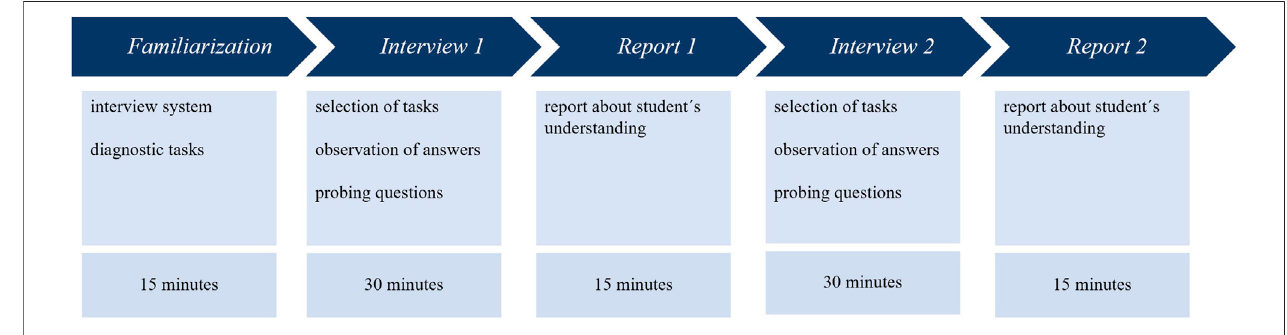
FIGURE 2 | Procedure of the simulation